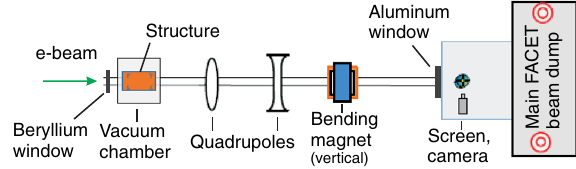
FIG. 11. Schematic of the experimental FACET section.